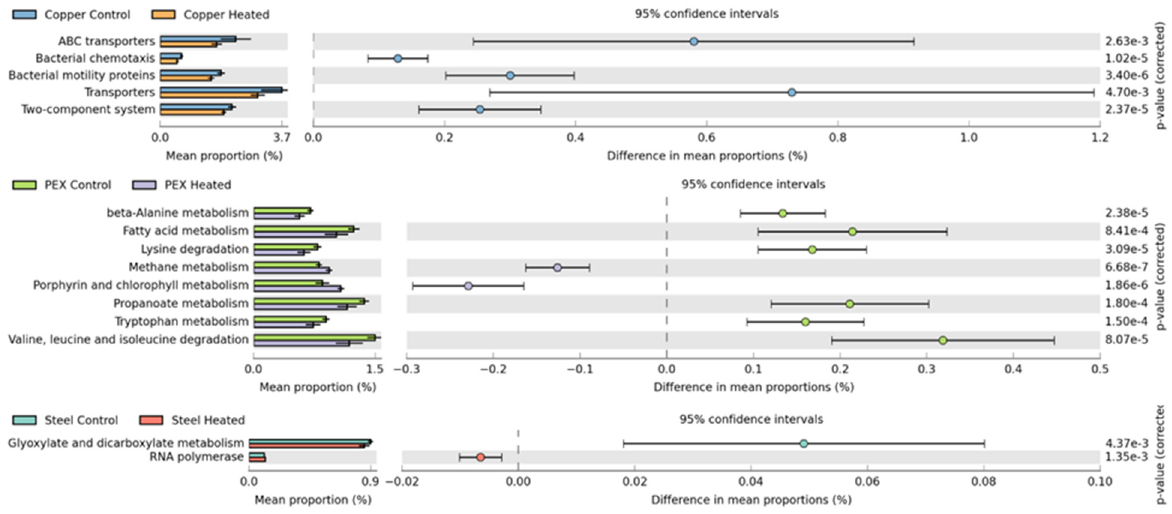
Figure 8. Statistically significant differentially abundant pathways between 32 °C and 22 °C systems.